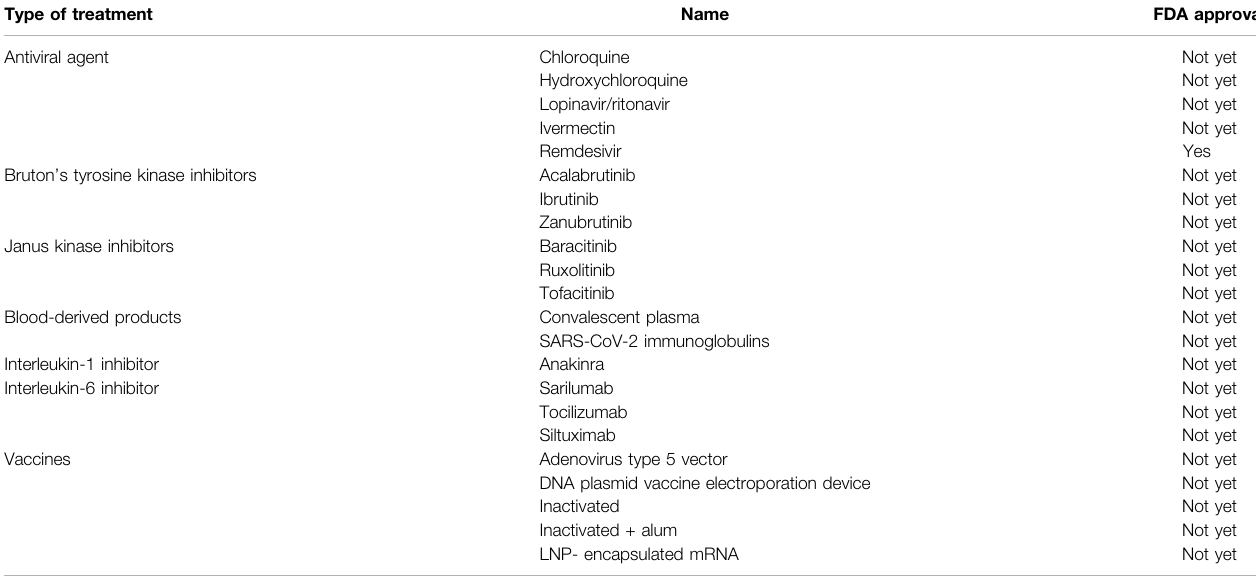
TABLE 1 | The current drugs or therapeutics in COVID-19 clinical